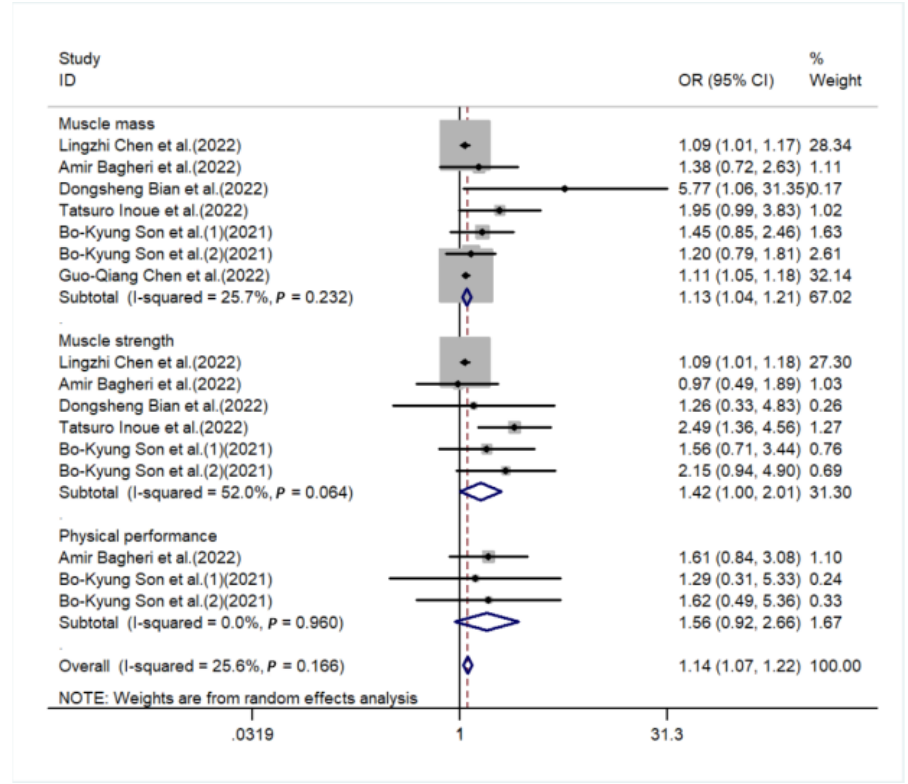
Figure 4. Forest plot for the subgroup of performance of sarcopenia [20,22–26].